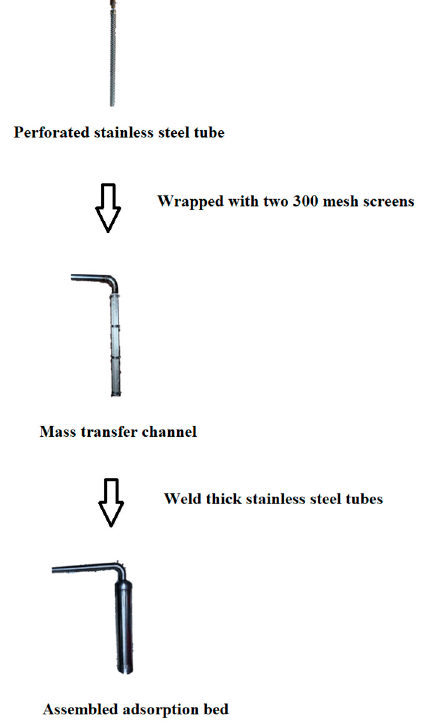
Figure 17. Production process of the adsorption bed.